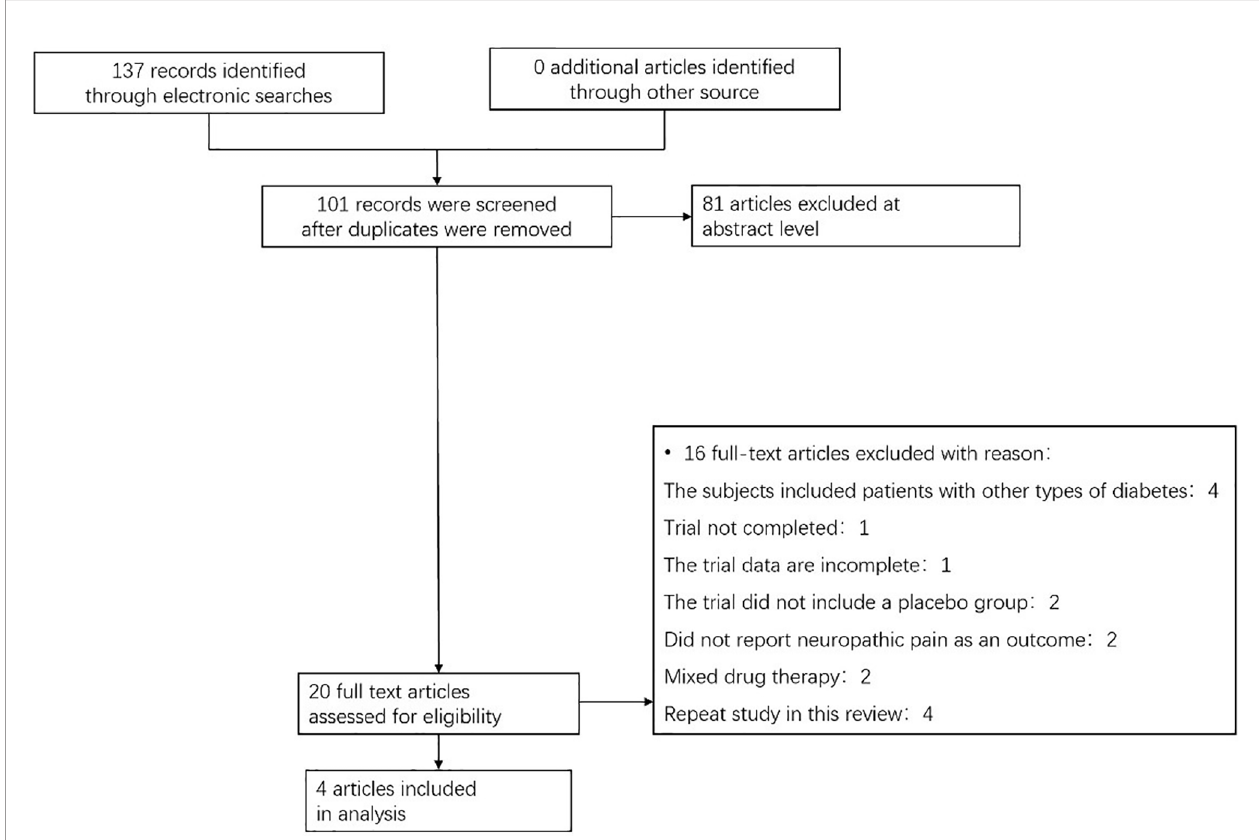
FIGURE 1 | Flow chart showing the process for inclusion of RCTs about patients with prediabetes or T2DM combined with NAFLD. RCTs, randomized clinical